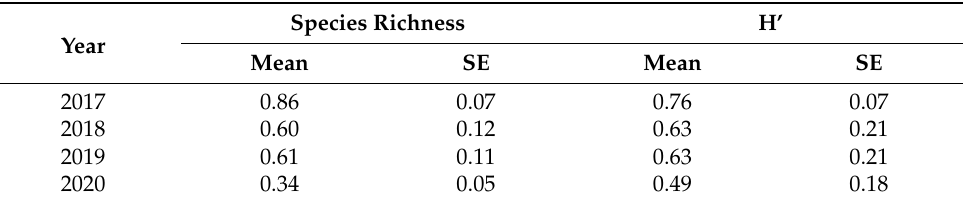
Table 8. Temporal variation in species richness and Shannon diversity (H’) of fish species elec- troshocked during surveys in August 2017, August 2018, September 2019, and November 2020 along a 700 m stretch in Ruby Run, a tributary within the Upper Deckers Creek watershed in Preston County, West Virginia, USA. Creek chub ( Semotilus atromaculatus ) followed by green sunfish ( Lepomis cyanellus ) was the most abundant species across years. Species richness values for each reach were calculated as the number of species present out of the total number of species surveyed for each year ( n = 3, 5, 4, and 10 species in 2017, 2018, 2019, and 2020, respectively).